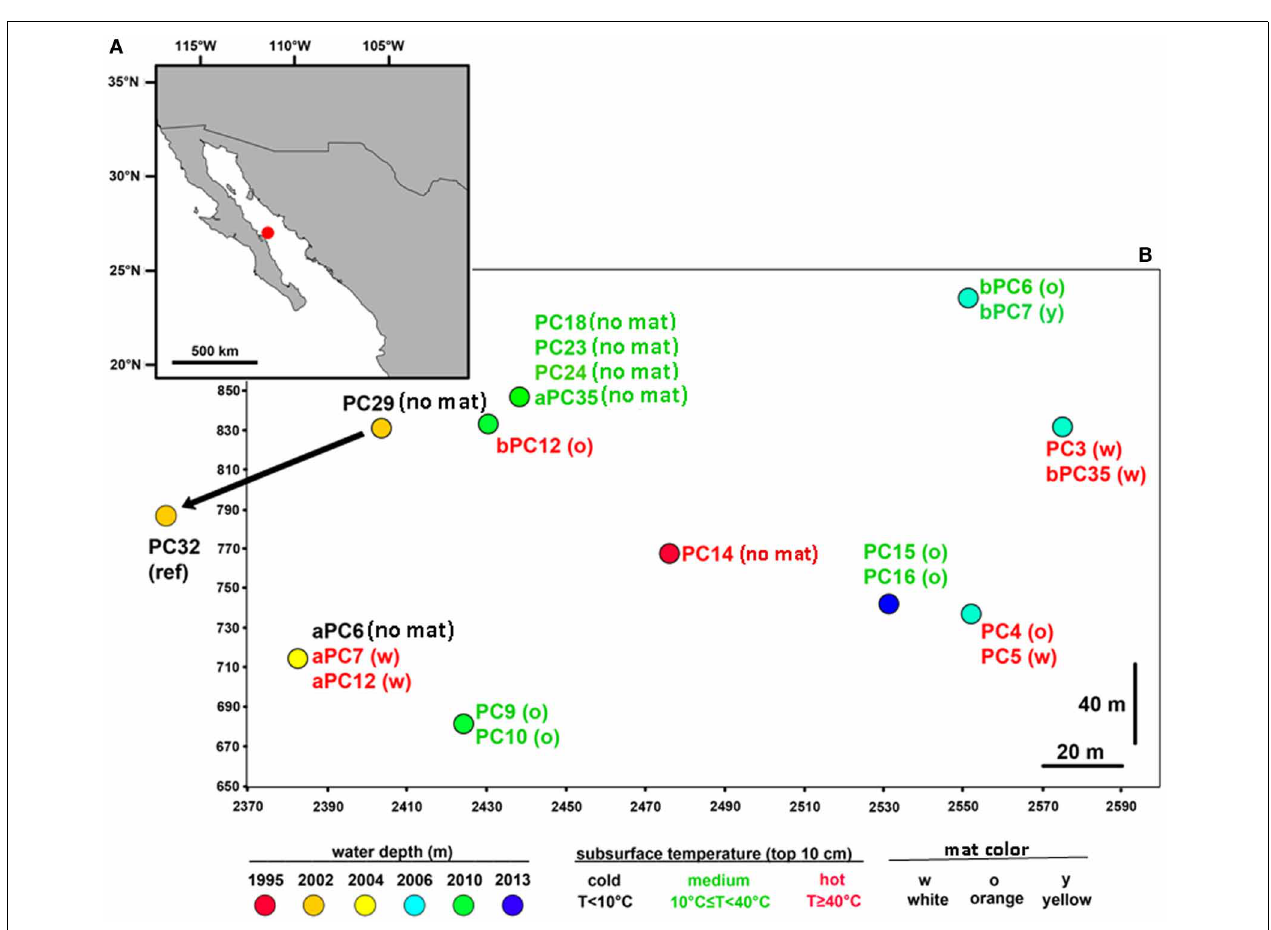
FIGURE 1 | Map of the sampled hydrothermal vent field. (A) Location of the vent field in the Guaymas Basin (Gulf of California, ∼ 2000m water depth); (B) In total, 21 sediment cores were retrieved from an area of 200 × 250m, including mat-covered and mat-free sediments. One non-hydrothermal sediment core (PC32) was sampled